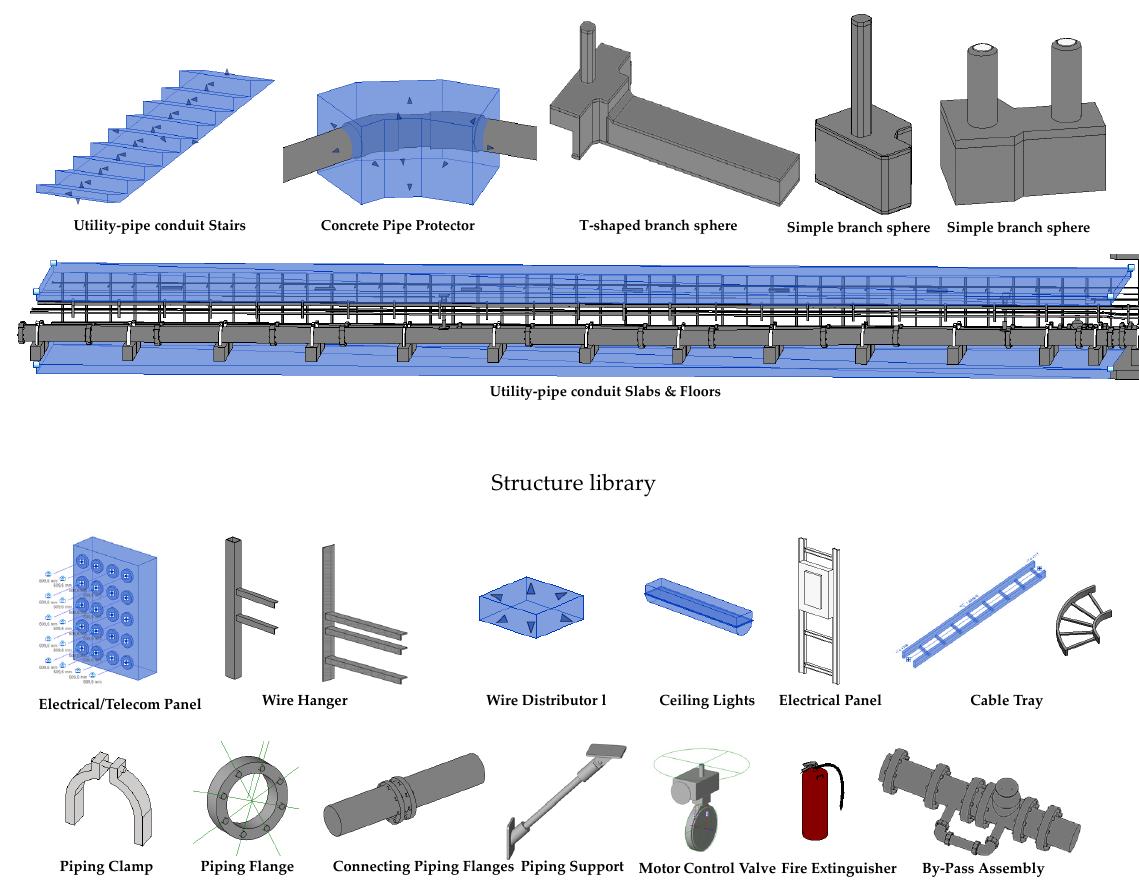
Figure 4. BIM model building procedure based on a laser scan.